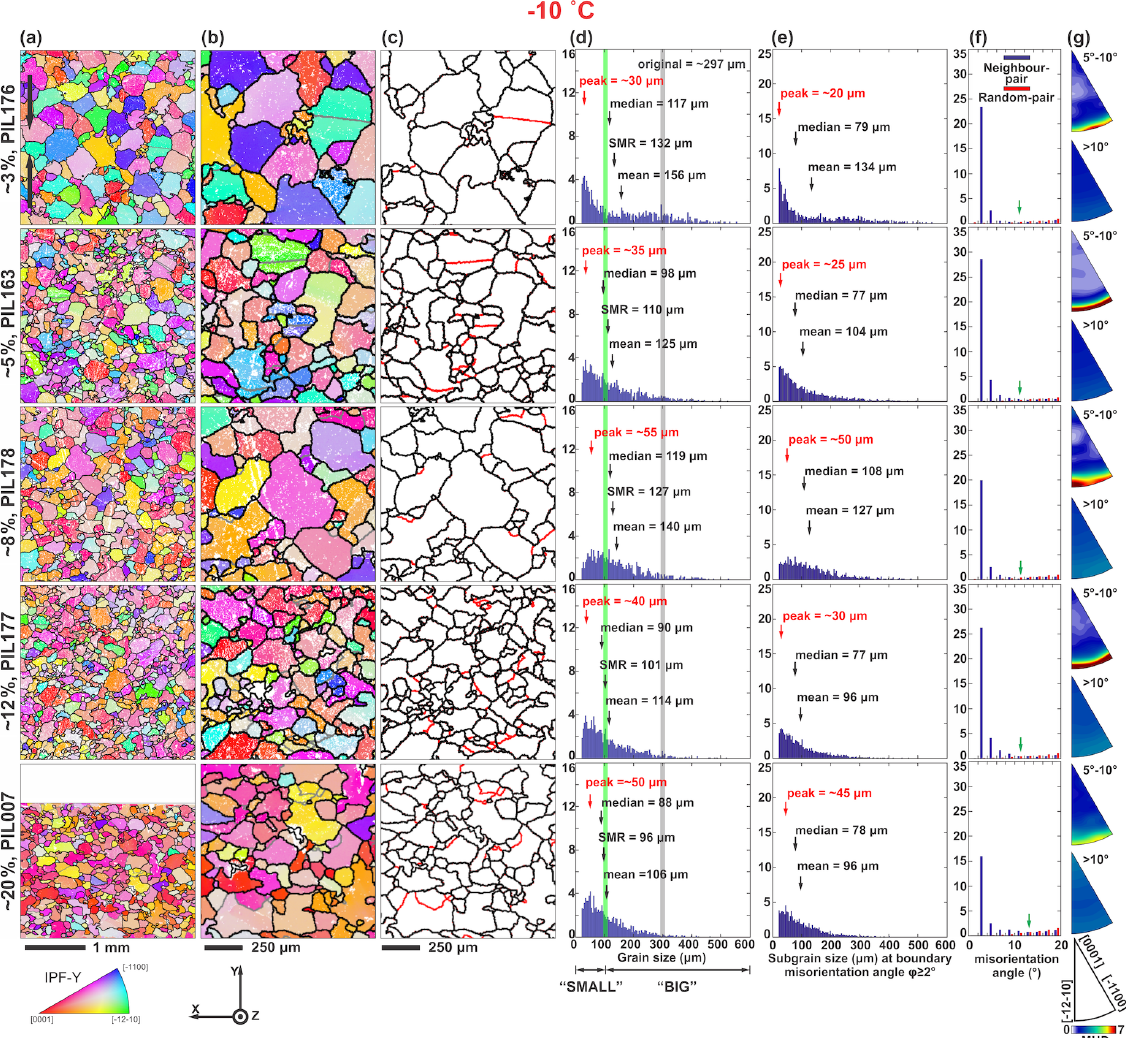
Figure 4. Microstructural analyses of deformed ice samples at − 10 ◦ C. Axial true strain increases from ∼ 3% on top to ∼ 20% on the bottom. The EBSD data collected with 5µm step size are presented as (a) orientation maps at low magnification and (b) orientation maps of selected areas at high magnification. Orientation maps are coloured by IPF-Y, which uses the colour map to indicate the crystallographic axes that are parallel to the vertical shortening direction as shown by the black arrows. Ice grain boundaries with a misorientation larger than 10 ◦ are shown in black. Non-indexed pixels are shown in white. Subgrain boundaries, where misorientation angles between neighbouring pixels are between 2 and 10 ◦ , are shown in grey. Maps show data without interpolation. (c) Distribution of subgrain boundaries. Subgrain boundaries are shown red. Grain boundaries are shown black. (d) Distribution of ice grain size presented in 4µm bins. Mean, median and square mean root (SMR) diameters are indicated by black arrows. The main peak of the grain size distribution is indicated by a red arrow. A vertical grey line marks the mean grain size of the starting material. A vertical green line marks the threshold grain size between “big grains” and “small grains” (see text). (e) Distribution of subgrain size presented in 4µm bins. The subgrain size is calculated by applying the boundary misorientation angle of ϕ ≥ 2 ◦ . (f) Distribution of neighbour-pair and random-pair misorientation angles. The misorientation angle at which neighbour-pair frequency reduces to be equal to the random-pair frequency is marked with a green arrow. (g) Misorientation axis distribution plotted in crystal reference frame as contoured inverse pole figure (IPF). The contoured IPFs are coloured by MUD. Neighbour- pair misorientation axes for neighbouring pixels with misorientation angles of 5–10 ◦ are presented in the upper box. Grain boundary ( > 10 ◦ ) misorientation axes using pixels along the grain boundaries of neighbouring grains are presented in the lower